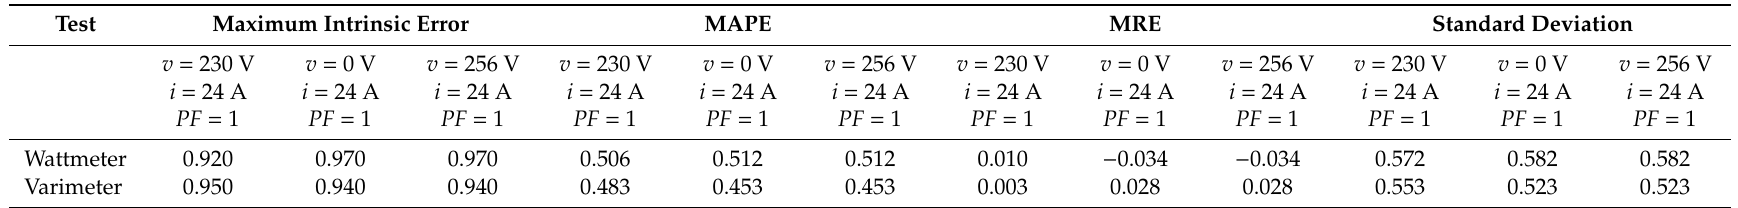
Table 10. Alternating current / voltage component variation test (wattmeter and varmeter, voltage, current, and PF variation): maximum intrinsic error (%), MAPE (%), MRE (%), and standard deviation